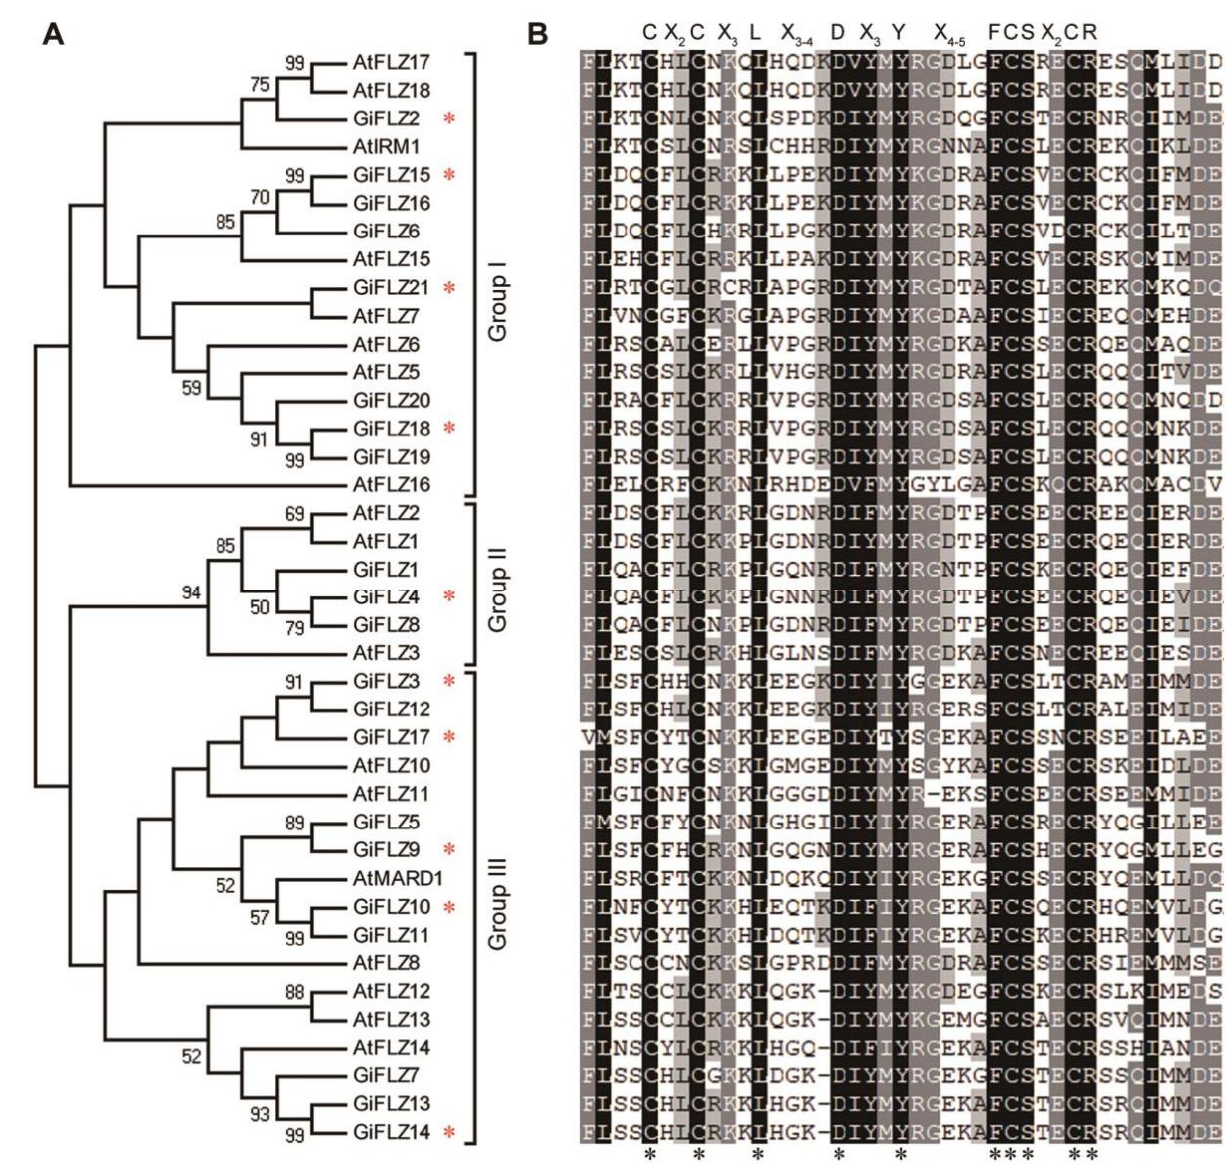
Figure 1. Phylogenetic tree and domain analysis of FLZ proteins. ( A ) Phylogenetic tree of FLZ proteins in G. inflata and Arabidopsis thaliana . The phylogenetic tree was constructed based on the multiple sequence alignments of FLZ proteins and generated with MEGA 5.0 software using the neighbor-joining method. The red asterisks marked the selected genes used in the subsequent study. ( B ) Protein sequence alignment of the FLZ domain. ClustalW was used for protein sequence alignment. The identical and similar amino acids in the FLZ domains were highlighted with dark and light gray backgrounds, respectively. The asterisks marked the conserved amino acids.